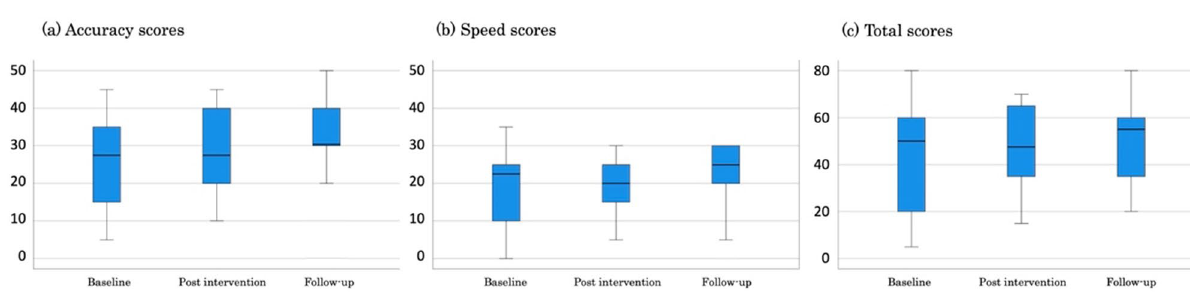
Figure 3. Palpation scores at each time point for the control group.